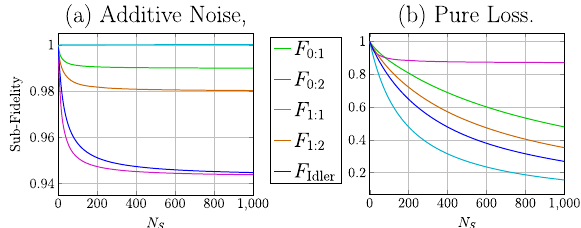
Fig. 7 TMSV sub- fi delities. Two-mode sub- fi delity behaviour with respect to increasing signal energy N S for unassisted, single-copy TMSV states interacting with m = 2 length channel patterns for a additive-noise channels ν T , ν B = 0.01, 0.02 and b pure-loss channels η = 0.97, η T , B